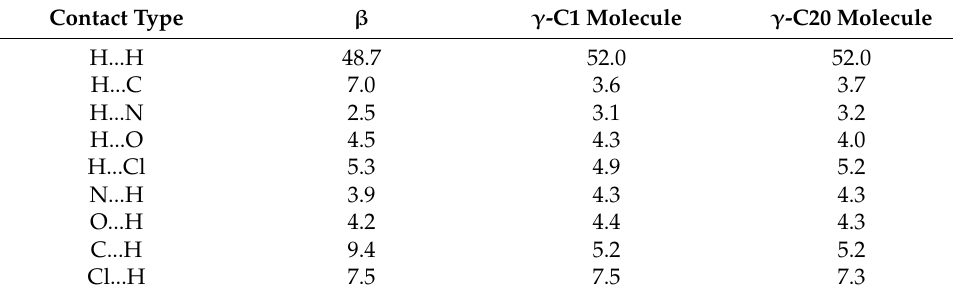
Table 2. Two-dimensional fingerprint percentage